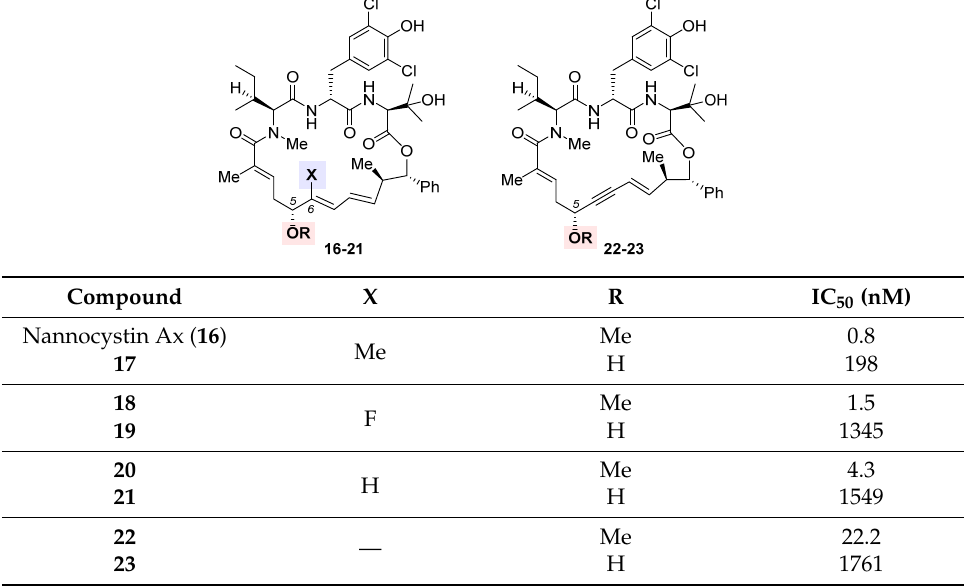
Table 1. Antiproliferative activity of nannocystin derivatives 16 – 23 against human colorectal carci- noma HCT-116 cells [80].